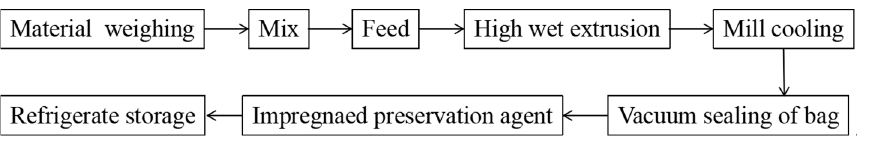
Figure 1. Process flow.